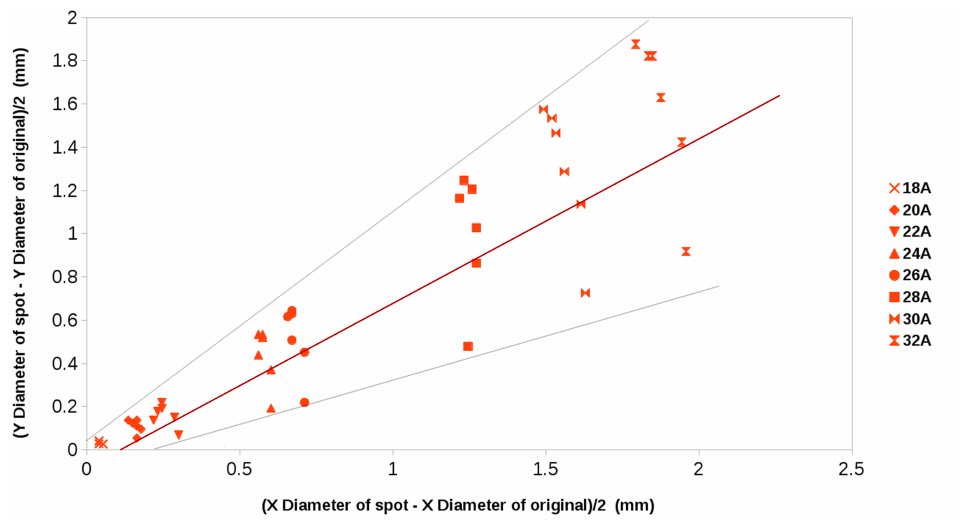
Figure 16. The variation in the x and y diameter of the six spot data with increasing magnetic field strength.